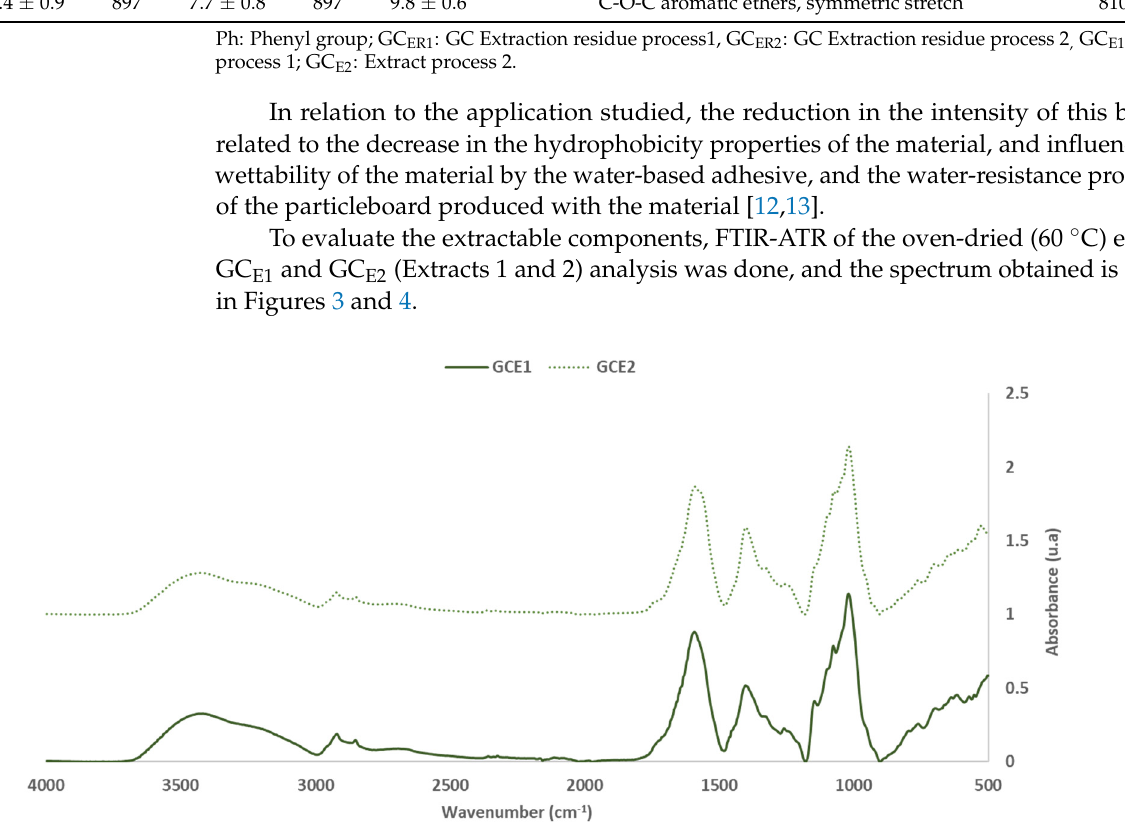
Figure 4. FTIR spectra: Grape cane extracts GC E1 , GC E2 (600–1800 cm − 1 ). Table 4 shows the characterization of the mains peaks of the two extracts (GC E1 and GC E2 ) in which the intensity values were normalized with the aromatic polyphenol ring vibration at 1600 cm − 1 . The band assignment was performed based on previous studies [15,20–24]. Table 4. FTIR peak assignment of grape cane extracts GG E1 and GG E2 . GG E1 GG E2 Group Range